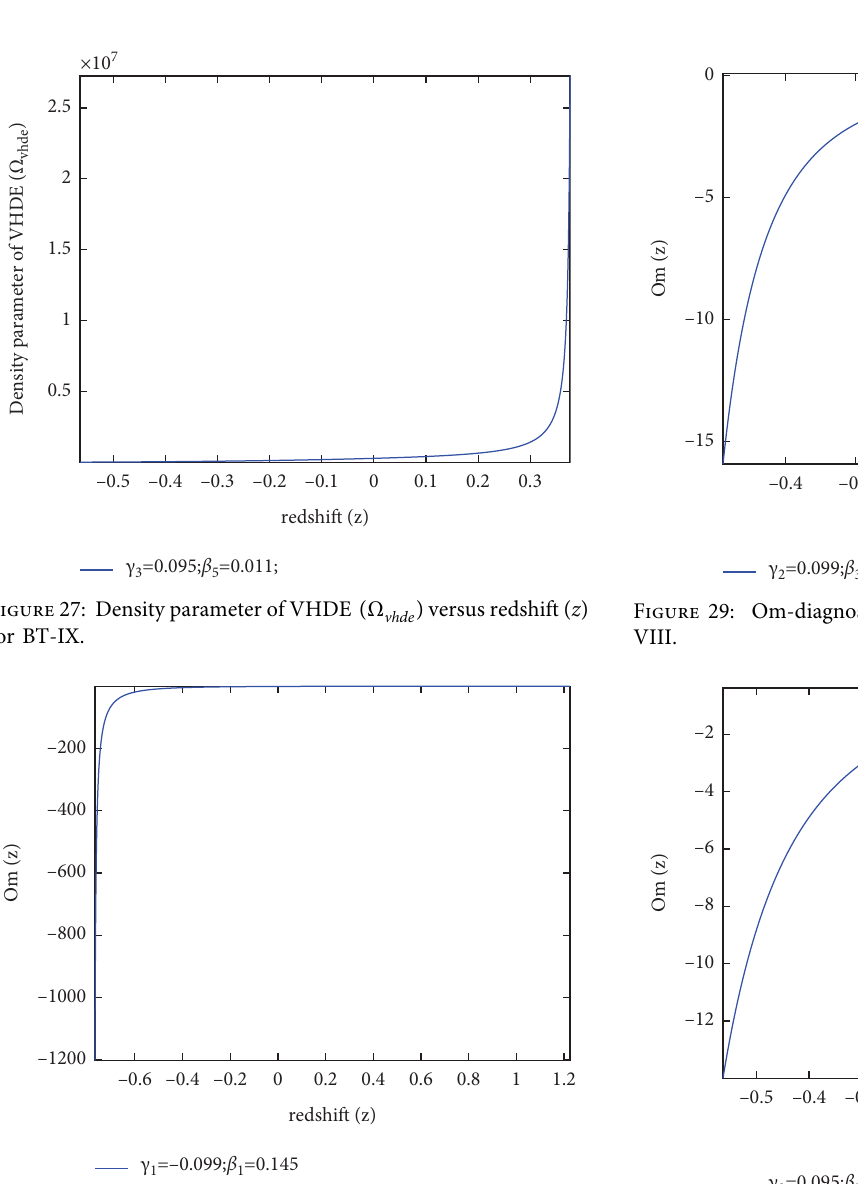
Figure 28: Om-diagnostics (Om( z )) versus. redshift ( z ) for BT-II.